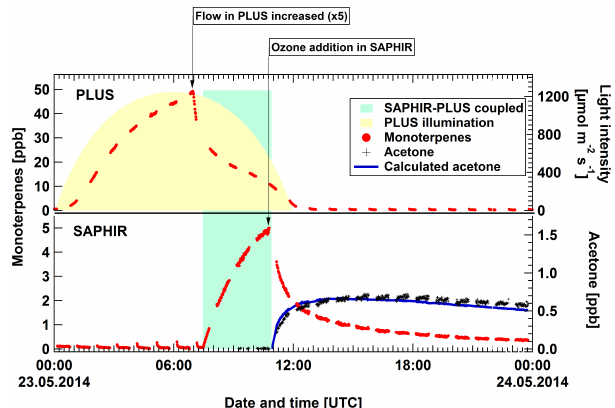
Figure 8. Temperature-dependent emission of Quercus ilex . 1h av- Figure 9. PLUS (upper panel) and SAPHIR (lower panel) observed eraged data of peak emissions during the photoperiod are used. Er- concentrations of monoterpenes (red symbols) in an experiment per- ror bars are calculated using error progagation based on the standard forming a pulsed transfer of BVOC emissions. After ozone addi- deviation for the concentration at 30 ◦ C and the measured temper- tion to the SAPHIR chamber, formation of oxidation products is atures. Result of the fit shows that monoterpene emissions increase observed. Acetone, as one representative OVOC, is shown as mea- with a slope of β = 0.11 ± 0.02. sured (black symbols) together with calculated acetone (blue ) Table 4. Fractional oxidation of individual BVOCs by ozone ( F O 3 and OH ( F OH ) together with maximum literature-reported acetone ) and OH oxidation ( Y OH ) taken to yields during ozonolysis ( Y O 3 calculate maximum weighted average acetone yield (Atkinson and Arey, 2003).